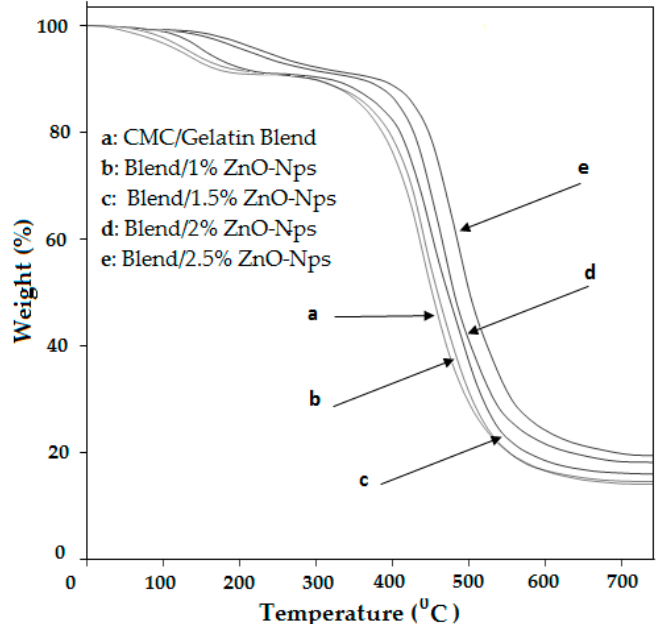
Figure 5. TGA of CMC/Gel/ZnO-nanocomposite hydrogels.